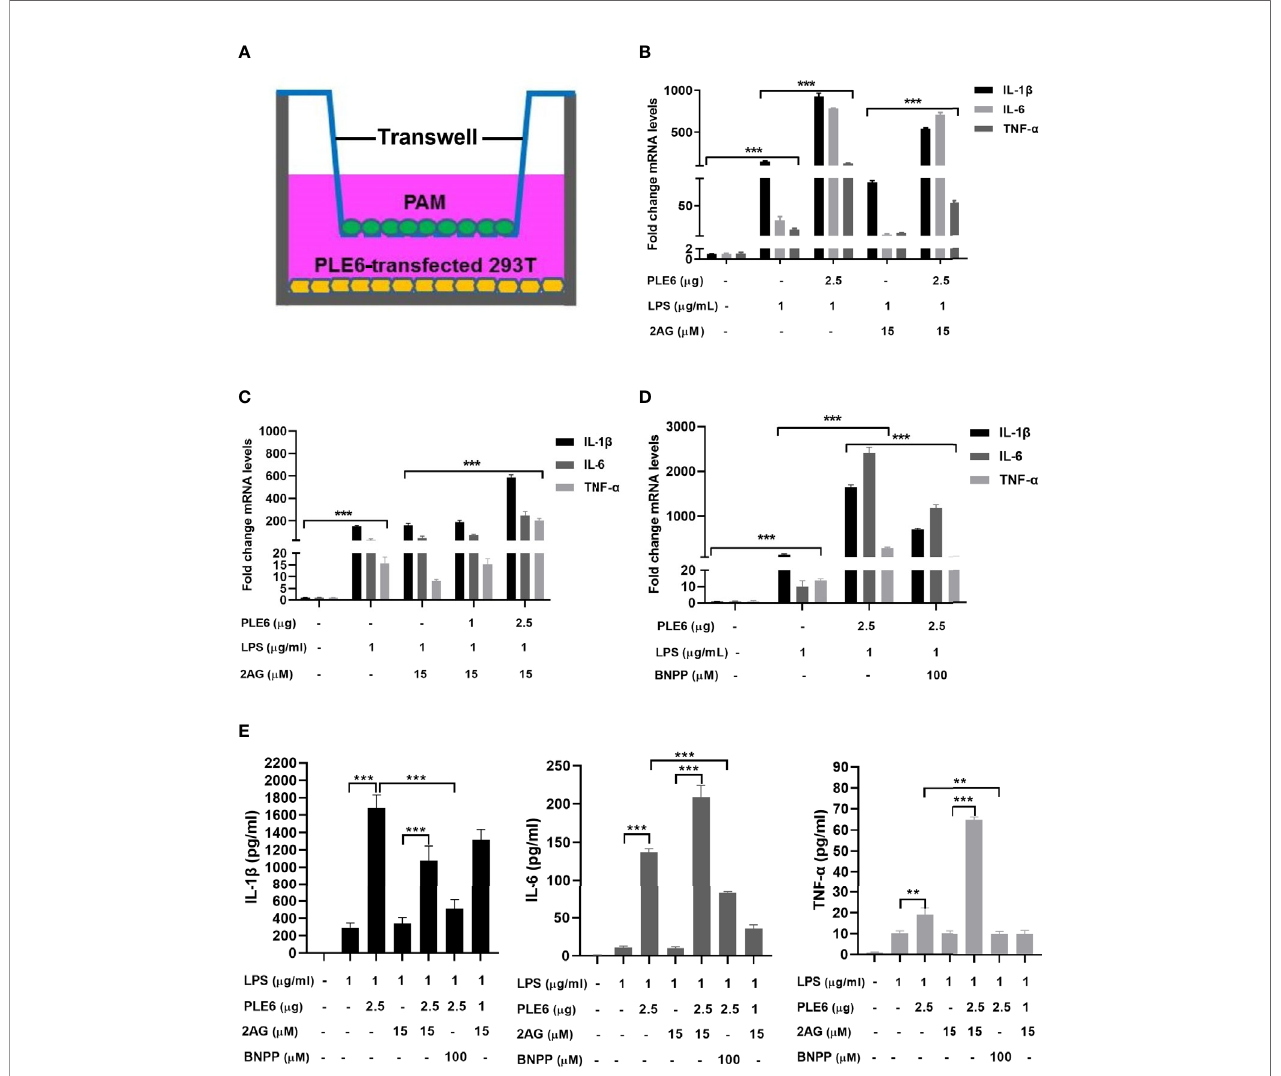
FIGURE 4 | Enhanced LPS-stimulation on the expression of proin fl ammatory cytokines in coculture model of PAMs and 293T cells. (A) Diagrammatic presentation of the coculture model. (B) Enhanced LPS-stimulation on the expression of proin fl ammatory cytokines in coculture model. PAM and PLE6-transfected 293T cells (non-transfected cells as controls) were cocultured for 24 h along with LPS (1 µg/mL), 2-AG (15 µM) or both. total RNA was isolated and analyzed for the mRNA level of proin fl ammatory cytokines by RT-qPCR. (C) Enhanced LPS-stimulation on the expression of proin fl ammatory cytokines in coculture model as a function of the amount of PLE6. Coculture was performed as described for Experiment B (above). However, the transfection of PLE6 plasmid was performed at 1 and 2.5 µg. (D) Reduced PLE6 increases on the expression of proin fl ammatory cytokines by BNPP. Coculture was performed similarly as described. However, cells were cocultured in the presence of BNPP at 100 µM. Likewise, the mRNA expression of proin fl ammatory cytokines was determined. (E) Effect of PLE6, 2-AG, BNPP or in combination on protein expression of proin fl ammatory cytokines in the coculture model. Cells were cultured and treated similarly. The levels of proin fl ammatory cytokines was determined with a protein chip. The data in Figure 4 are presented as the mean ± SEM of 3 independent experiments. Statistical signi fi cance was indicated by asterisks (** P < 0.01; *** P <